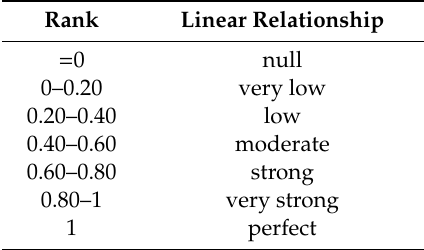
Table 1. Interpretation of correlation coe ffi cients (Bisquerra 1989, p. 189, our own